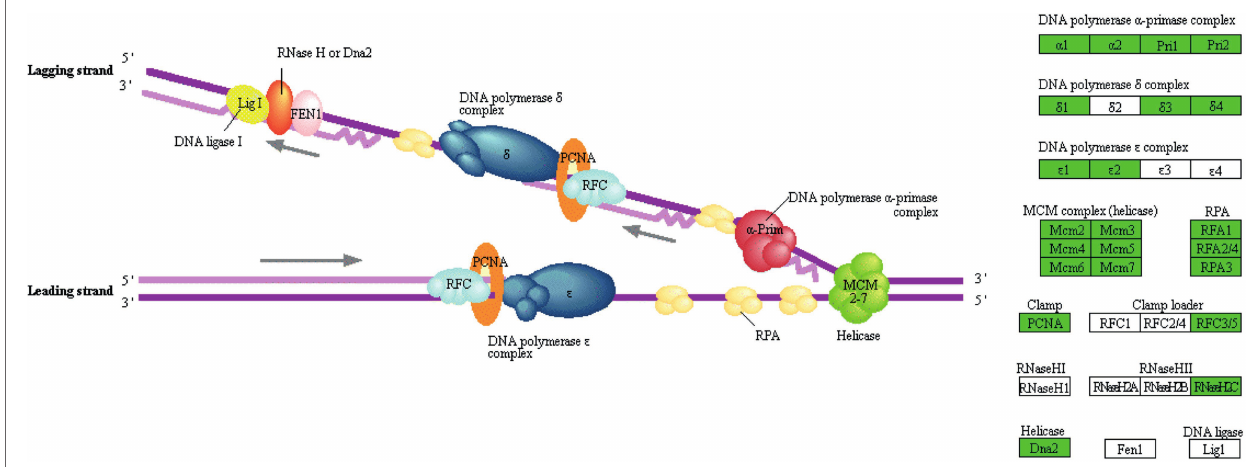
FIGURE 6 | KEGG (Kyoto Encyclopedia of Genes and Genomes) pathway of DNA replication where enzymes/proteins from the DEGs (differentially expressed genes) are located (Green boxes on the right indicate DEGs with down-regulated expression, whereas white boxes indicate no change in